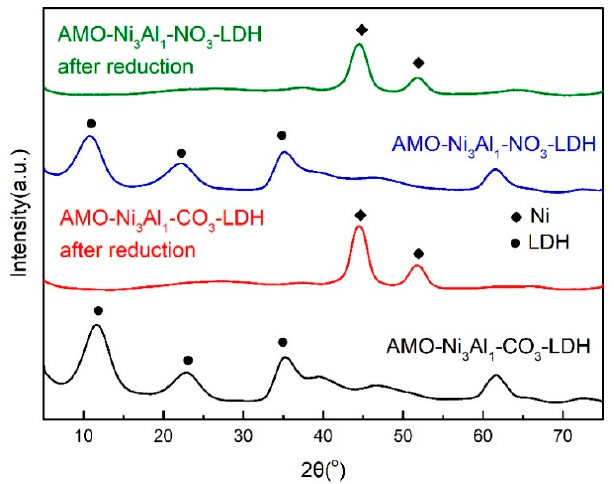
Figure 1. The powder XRD patterns of AMO-Ni 3 Al-NO 3 LDH and AMO-Ni 3 Al-CO 3 LDH precursors and their corresponding reduced samples.